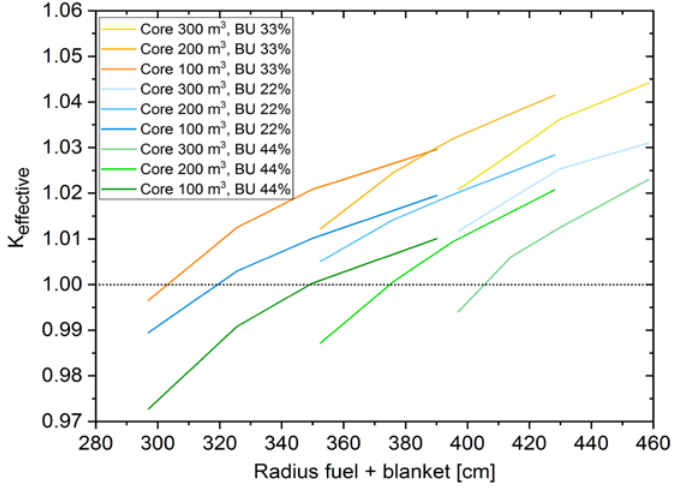
Figure 4. Blanket optimization. Neutron multiplication factor of reactors with different core volumes, blanket volumes and total